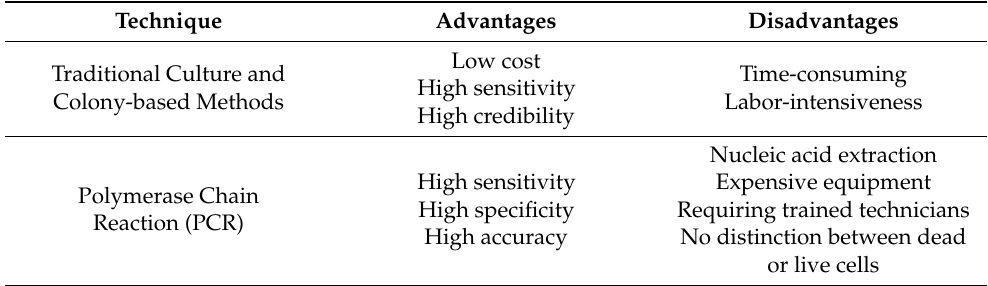
Table 1. Advantages and Disadvantages of Different Foodborne Pathogen Detection